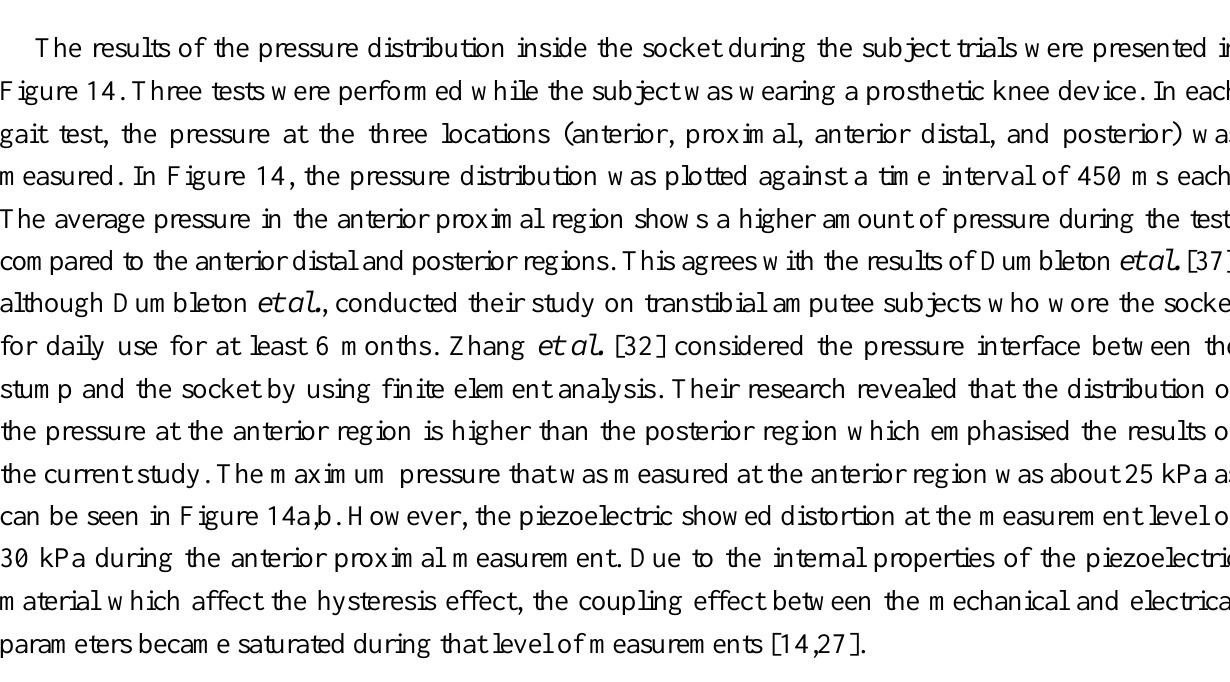
Figure 14. Stump/socket pressure distribution of transfemoral amputee subject during gait, ( a ); ( b ) and ( c